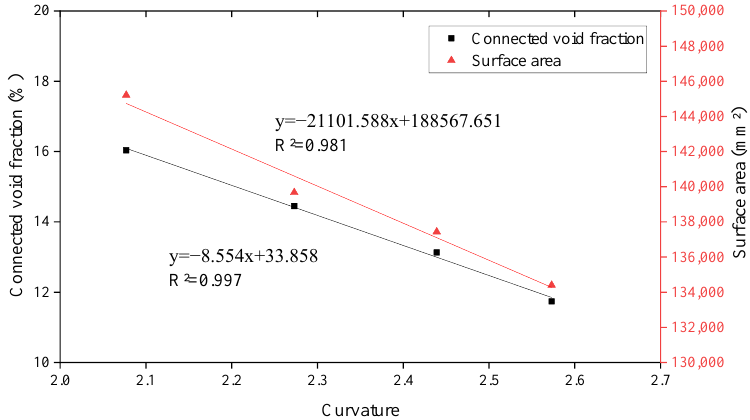
Figure 10. Relationship curve between the connected void fraction, surface area, and curvature curve